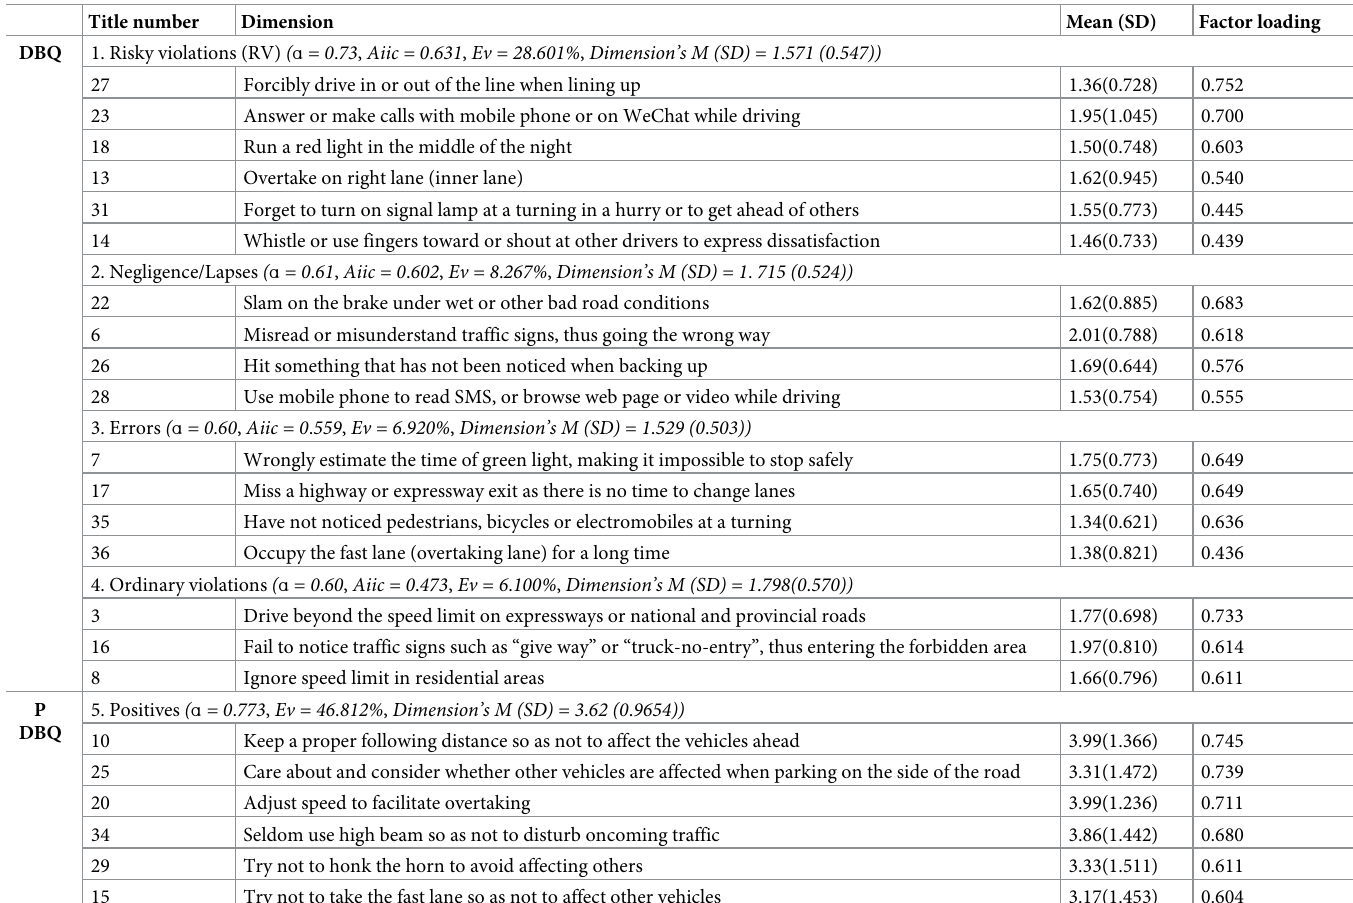
Table 2. Factor structure of DBQ and